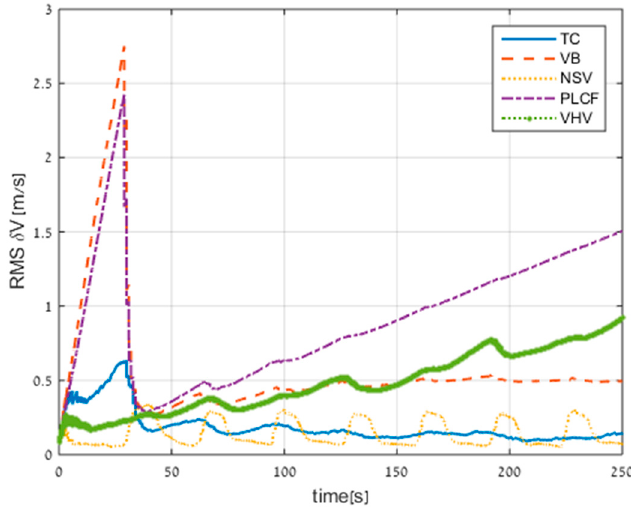
Figure 13. RMS errors of velocity for all approaches obtained from trajectory #3.